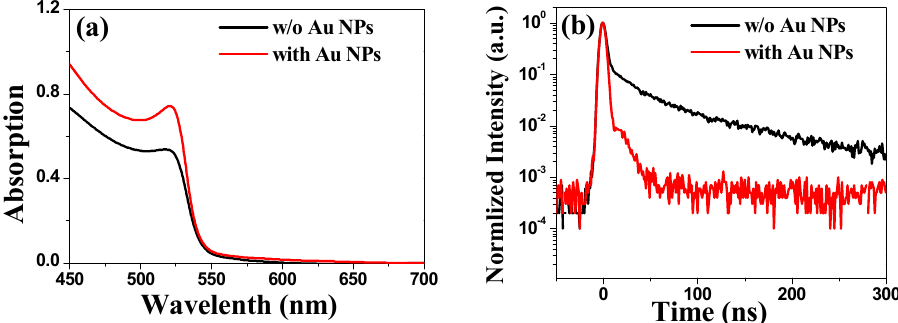
Figure 5. ( a ) UV-vis spectra, ( b ) time-resolved PL spectra in the devices’ structure: Quartz/PEDOT: PSS/MAPbBr 3 (with and w/o Au NPs).